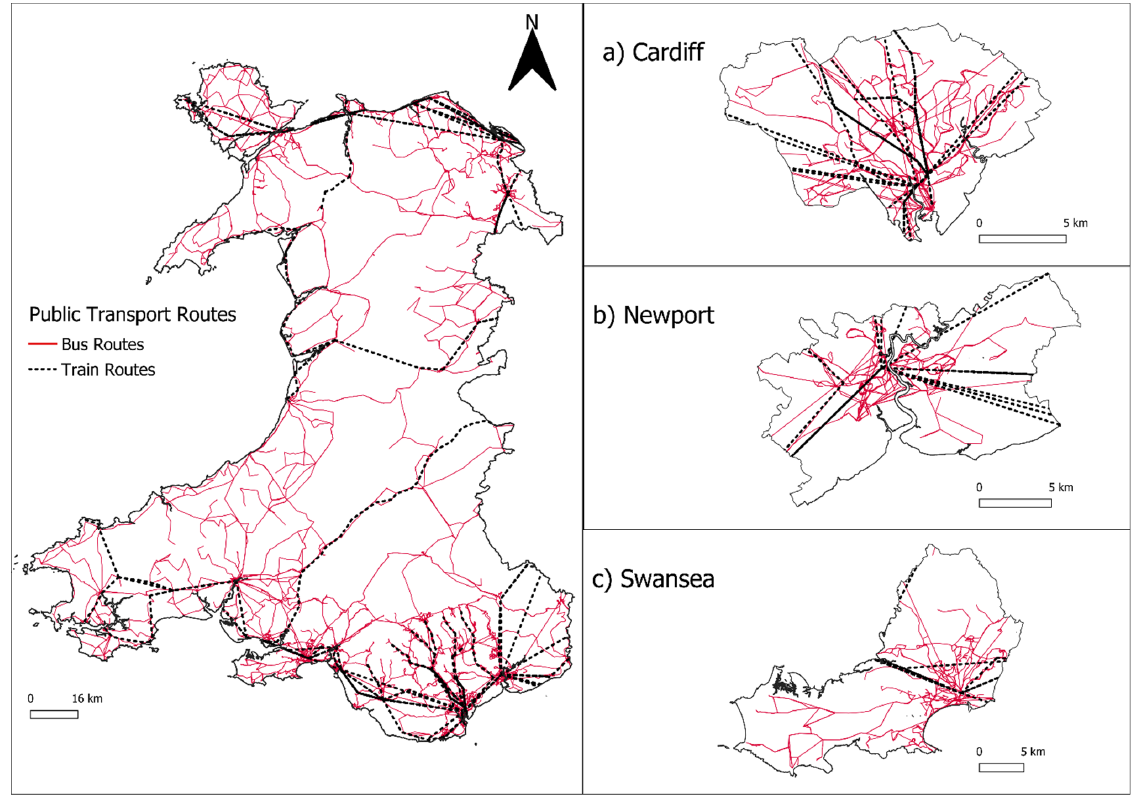
Figure 3. Public transport network consisting of bus routes and light and heavy rail. Insert maps ( a – c ) illustrate further details within three major